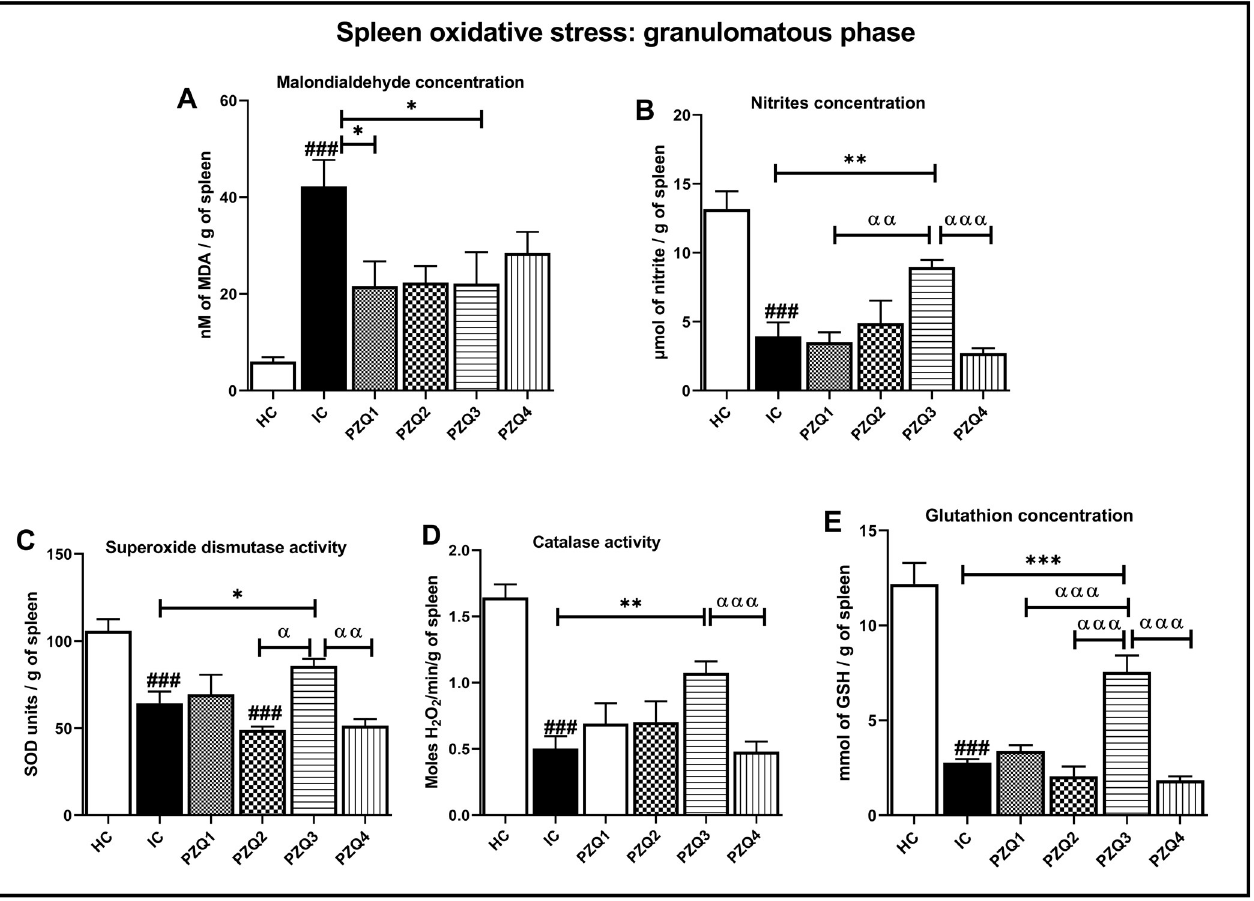
Fig 7. Effect of praziquantel treatment on the splenic oxidative status during the granulomatous phase in Schistosoma mansoni -infected mice. (A) malondialdehyde, (B) nitrites, (C) superoxide dismutase, (D) catalase, and (E) Reduced glutathione. HC: Uninfected mice, IC: Infected-untreated mice, PZQ1: Infected mice treated with praziquantel at 100 mg/kg for 5 consecutive days, PZQ2: Infected mice treated with praziquantel at 100 mg/kg for 28 consecutive days, PZQ3: Infected mice treated with praziquantel at 18 mg/kg for 28 consecutive days, PZQ4: Infected mice treated with a single dose of praziquantel at 500 mg/kg. Data are expressed as mean ± SEM (n = 6). ANOVA followed by Tukey multiple comparison test was also used for statistical analysis. ### p < 0.001: values are significantly different from those uninfected mice (group HC). � p < 0.05, �� p < 0.01, ��� p < 0.001: values are significantly different from those of infected-untreated mice (group IC). α p < 0.05, αα p < 0.01, ααα p < 0.001: values are significantly different from those of infected mice treated with PZQ3 posology (group PZQ3).